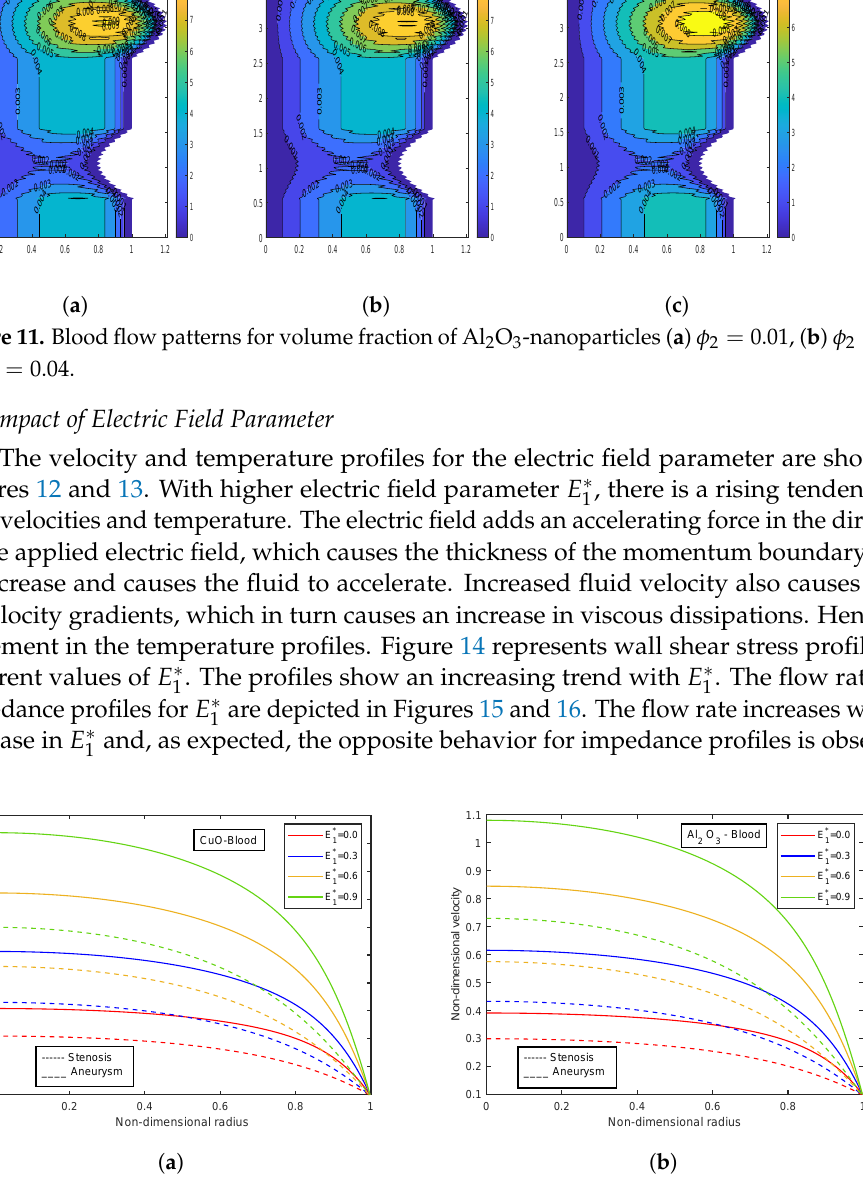
for ( a ) CuO-nanoparticles, ( b ) Al 2 O 3 - 1